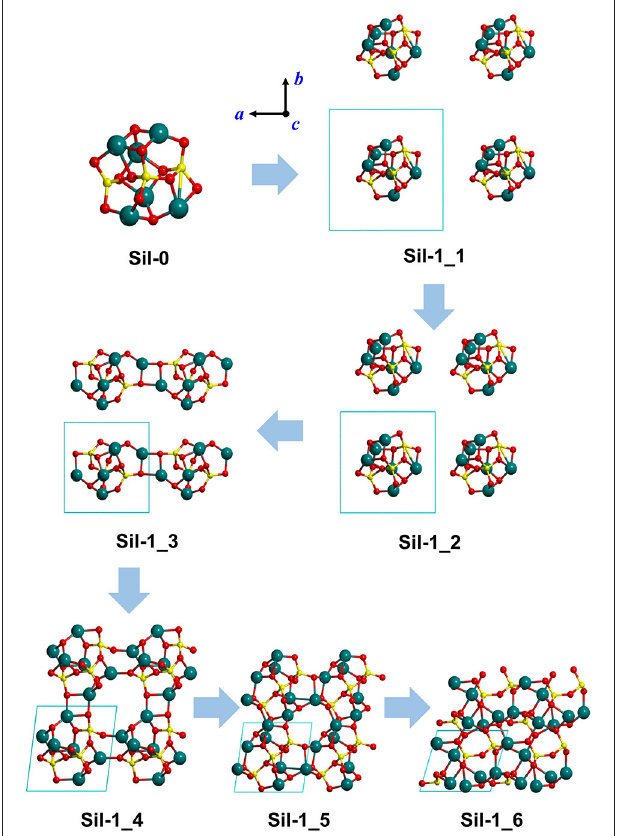
FIGURE 1 | Optimized silicate structures derived from the progressive reduction of the periodic unit cell size as a strategy to mimic proto-silicate aggregation. For Sil-1_1, Sil-1_2, and Sil-1_3, unit cell parameters were fixed to the initial values, while for Sil-1_4, Sil-1_5, and Sil-1_6 they were included in the optimization process. Atom color key: Si—yellow, Mg—blue,